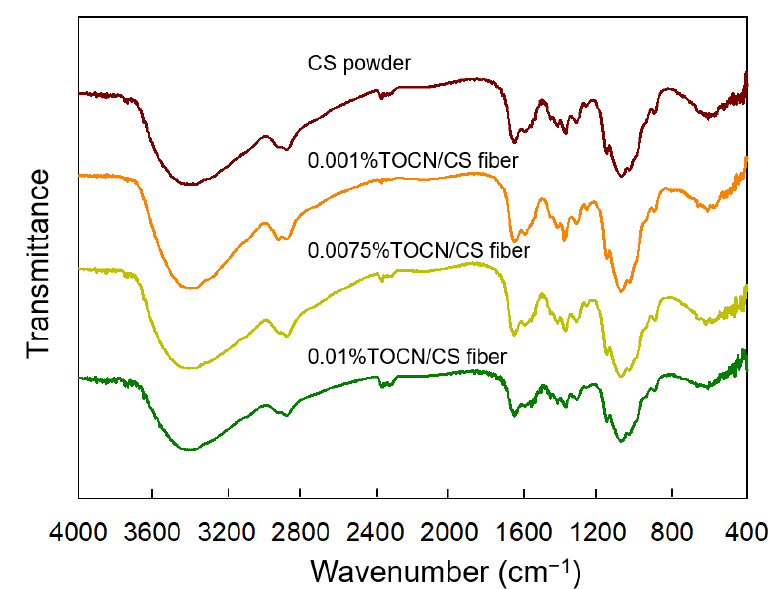
Figure 6. FTIR spectra for CS powder and CS/TOCN composite fibers.